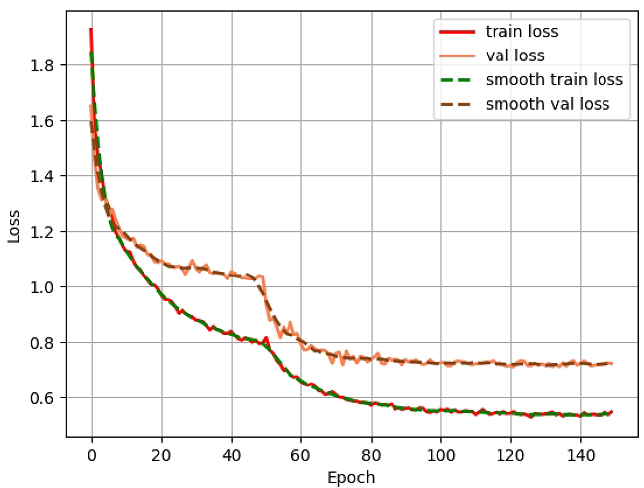
Figure 5. Training loss under the VGG16 backbone